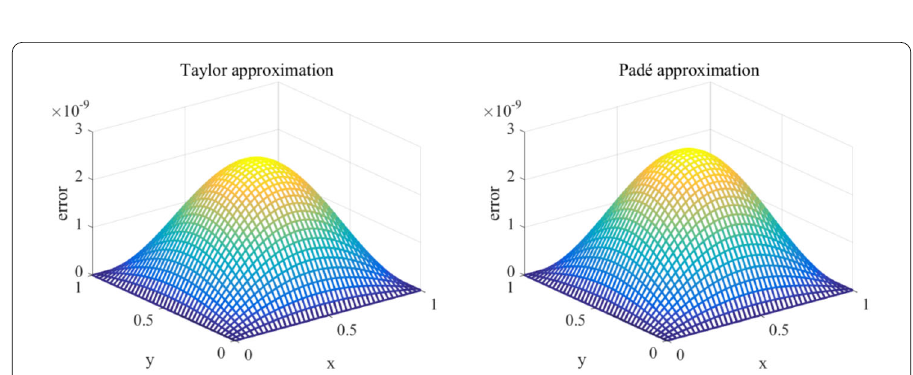
Figure 12 The CFDS-PIM solutions of the Taylor approximation (on left-hand side figure) and Padé approximation (on right-hand side figure) for two-dimensional problem with N = 41 × 41 at t = 2 for case 1 of Example 4